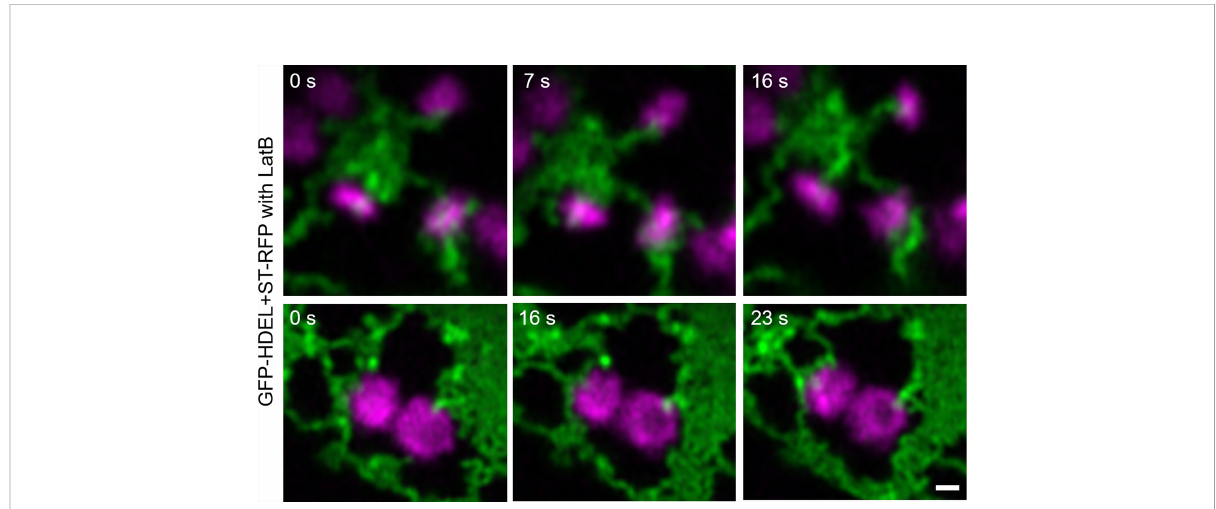
FIGURE 6 Changing ER dynamics with latrunculin B (LatB). The ER and Golgi markers GFP-HDEL (green) and ST-mRFP (magenta) are coexpressed in tobacco leaf epidermal cells, tobacco leaf pieces were treated with LatB and videos were taken. Time frames [s] are indicated. Size bars = 0.5 µm.